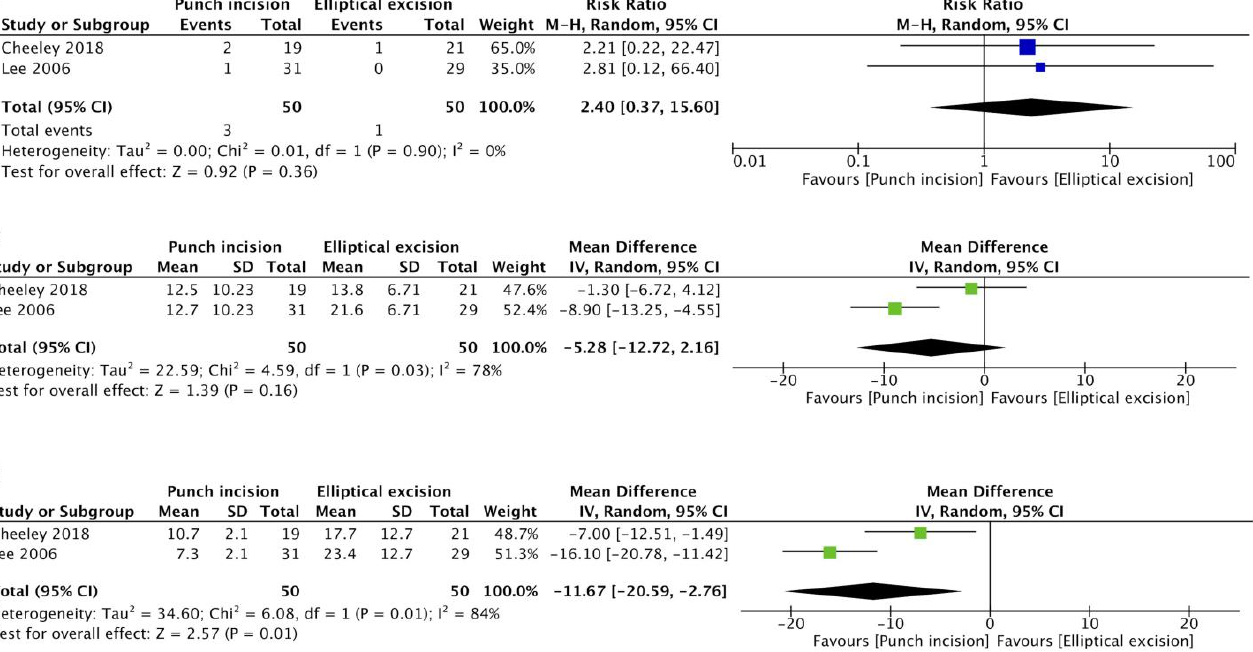
Table 3. Summary of Findings (SoF).